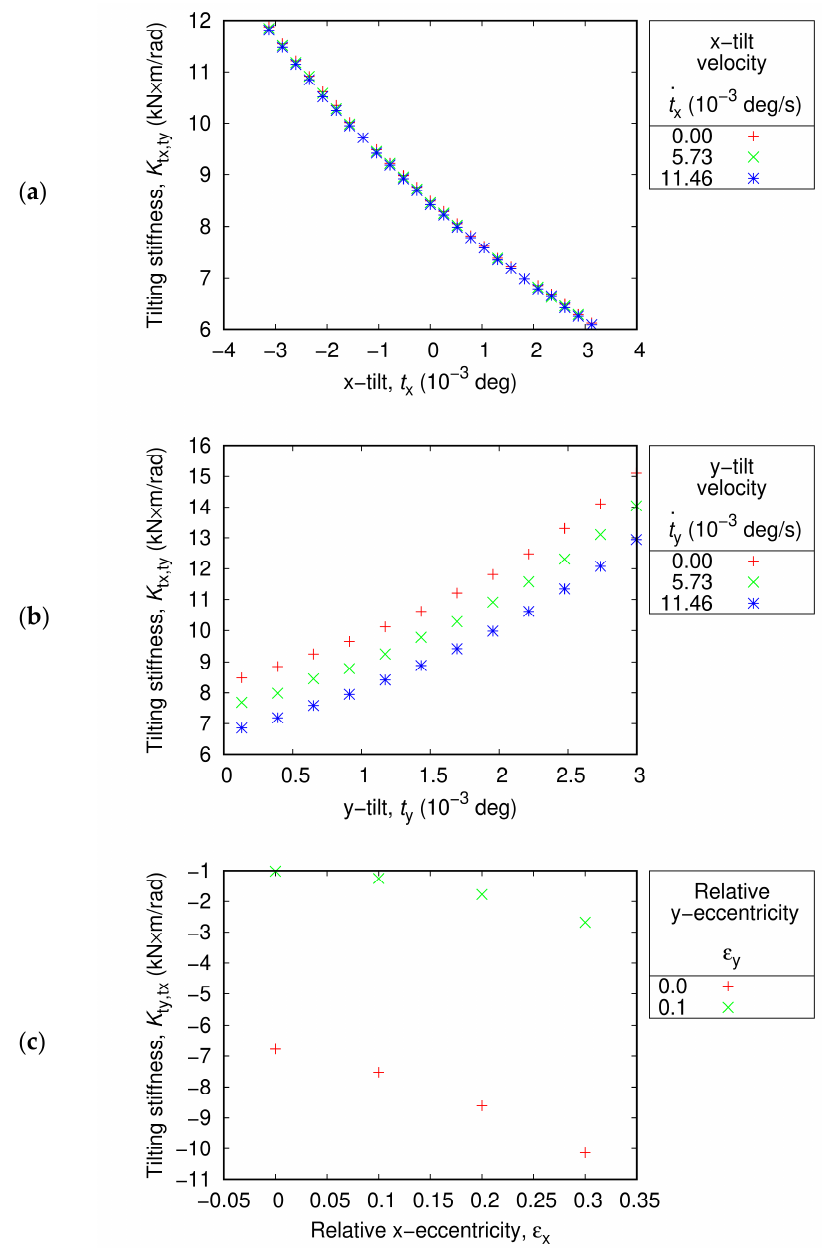
Figure 5. Parameter sensitivity of the cross-coupled stiffness coefficient K tx , ty : ( a ) Effects of tilting angle and tilting velocity in the x-direction; ( b ) Effects of the tilting angle and tilting velocity in the y-direction; ( c ) Effects of relative eccentricities. All unreferenced parameters have zero values. K ty , tx , which is another cross-coupled stiffness coefficient, is of the same order of mag- nitude; however, it is negative, and falls in the range of − 18–0 kN·m/rad (refer to Figure 6). It is not sensitive to (cid:1872)(cid:4662) (cid:3051) , and the (cid:1872)(cid:4662) (cid:3052) effect on it is also negligible (see Figure 6a,b). The magnitude of K ty , tx is higher at lower (cid:1872) (cid:3051) and (cid:2013) (cid:3052) and at higher (cid:1872) (cid:3052) and (cid:2013) (cid:3051) .